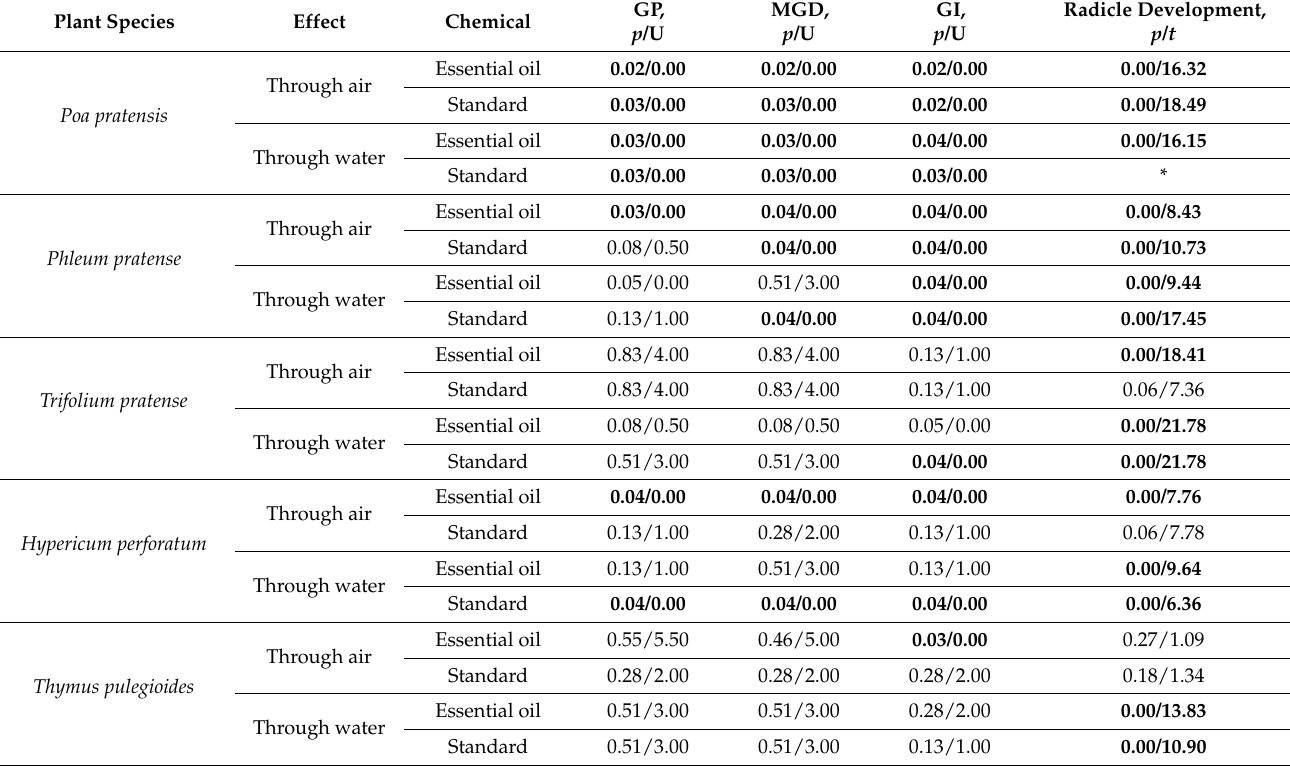
Table 5. Mann–Whitney U-test of germination and Stjudent t -test of radicle development of Poa pratensis, Phleum pratense, Trifolium pratense, Hypericum perforatum , and Thymus pulegioides (GP—germination percentage, MGD—mean daily germina- tion, GI—germination index, U—U value of Mann–Whitney test, t —Stjudent coefficient, p —significant value). Significant level was chosen as p < 0.05; the significant differences with control are indicated in bold.